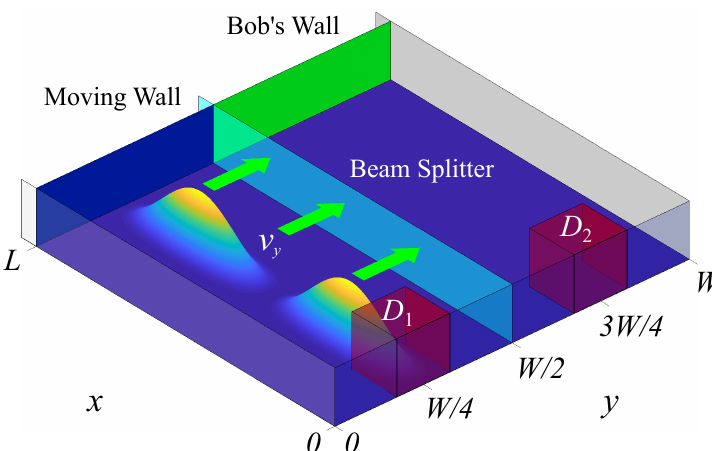
Figure 2. A thought experiment allowing communication via the nonlocal phase of the wavefunction. The walls of the cavity are initially at rest, the harmonic potential is turned off, and the detectors are not yet in place. The particle begins in the state ψ n ( x , t = 0 ) g ( y , t = 0 ) , where ψ n ( x , = 0 ) is an excited x -mode of the cavity ( n = 2 is depicted), and g ( y , t = 0 ) is a narrow Gaussian initially centered at W /4 with average velocity v y > 0. When the packet has divided at the beam splitter, the harmonic potential ( 1/2 ) m Ω 2 ( t ) x 2 is turned on throughout the cavity, and the wall segment at ( x = L , y < W /2 ) begins 1 to move as L 1 ( t ) . At the same moment, Bob chooses whether the wall segment at ( x = L , y > W /2 ) begins to move as L 1 ( t ) (Message 0) or L 2 ( t ) (Message 1). The two half-packets propagate along y , then bounce off their respective walls and meet back at the beam splitter, a period T = W / v y after they left it. Bob choosing L 1 ( t ) results in perfect interference, so the entire pulse recombines on the y > W /2 side of the beam splitter, whereas choosing L 2 ( t ) results in a phase difference so that the interference is no longer perfect. Alice can detect Bob’s choice at t = 3 T /2 = 3 W /2 v y by inserting detector D 1 at W /4 and detector D 2 at 3 W /4 and measuring the relative intensity for the entire ensemble of cavities. L 1 ( t ) , L 2 ( t ) , and Ω 1 ( t ) are all periodic function of time, with period T